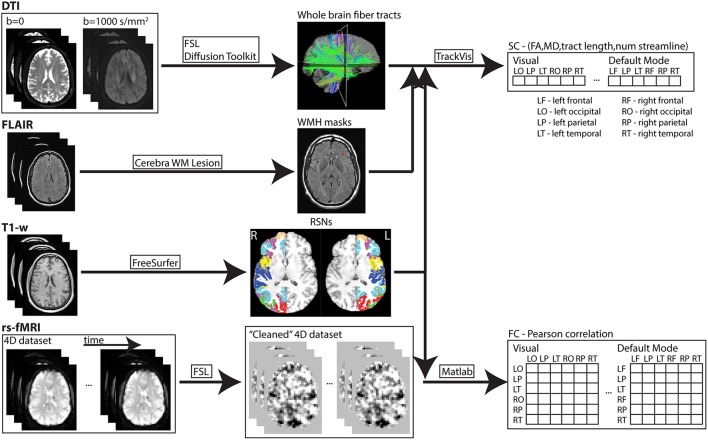
In-house developed pipeline used to process MR imaging data of each subject. Data processing and analysis through this pipeline was performed on an iMac (2.9GHz quad-core Intel Core i5; 32GB 1600MHz DDR3 memory) and high performance computing clusters (https://www.westgrid.ca; used to generate cortical surface labels—explained above). SC and FC measures were derived for each resting-state network (RSN). Subsequently, the values of each connectivity measure were averaged in each network.